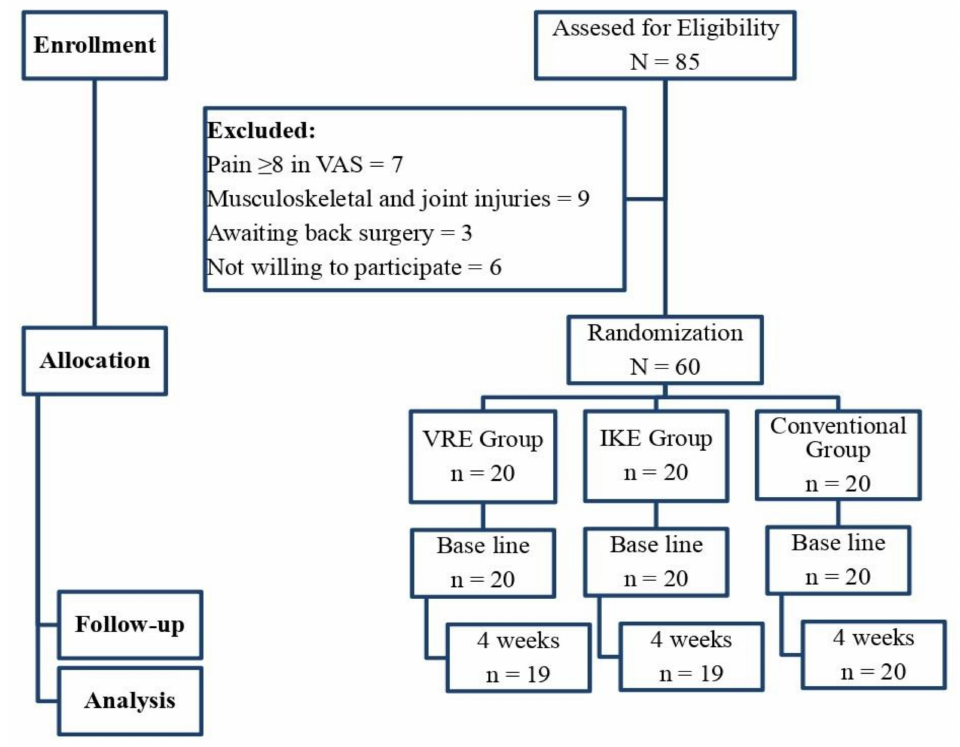
Figure 1. Flowchart showing the study